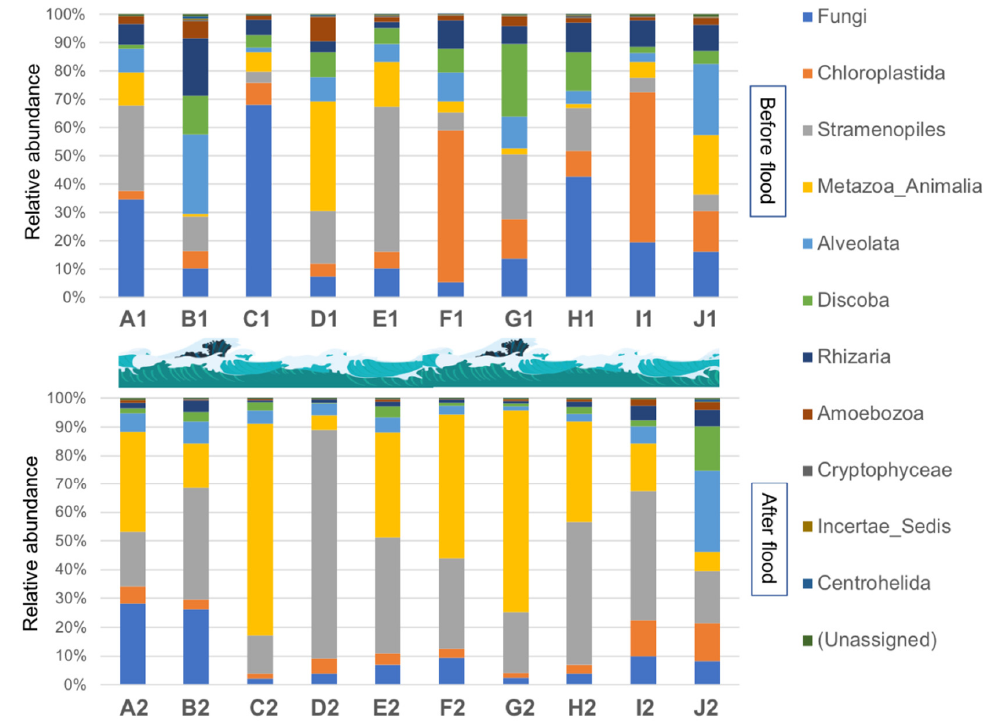
Figure 2. Relative abundance of dominant kingdoms of the eukaryotic communities. At the class level, the most abundant group was Diatomea both before and after the floods. Its average abundance increased from 13.26% before the floods to 32.61% after the floods (Figure 3b). Embryophyta and Kinetoplastea followed by Diatomea were the top three abundant groups before the floods, while Clitellata and Maxillopoda were identified as the second and third most abundant groups after the floods. The dominant eukaryotic orders were Bacillariophytina (10.87%), Liliopsida (6.98%), and Metakinetoplastina (5.58%) before the floods. After the floods, Bacillariophytin was also the most abundant order, accounting for 21.79% of the total sequences, followed by Chaetonotida (15.03%), and Haplotaxida (8.62%). The relative abundance of Bacillariophytin, Chaetonotida, Haplotaxida, Calanoida, and Coscinodiscophytina all showed an obvious increase after the floods (Figure 3c). Mediophyceae, Incertae_Sedis, and Bacillariophyceae were the top three most abundant families before the floods, accounting for 5.74%, 5.71%, and 4.02% of the total sequences on average. After the floods, the relative abundance of Mediophycea increased to 17.87%, thereby remaining the most abundant group (Figure 3d). The abundance of Incertae_Sedis decreased to 0.57%, conferring the second highest abundance of Melosirids (6.84%). Bacillariophyceae was the third most abundant group, but only comprised 1.78% of the total. The top five dominant genera from sediment samples collected before floods were Cyclotella (3.94%), Phymatotrichopsis (1.98%), Navicula (1.39%), Melosira (1.16%), and Ichthyobodo (1.13%). The abundance of Thalassiosira and Melosir both showed obvious increases after the floods (Figure 3e). Only three genera, including Thalassiosira (10.04%), Melosira (6.15%), and Cyclotella (4.62%) each accounted for more than 1% of the abundance in the sediments after the floods.